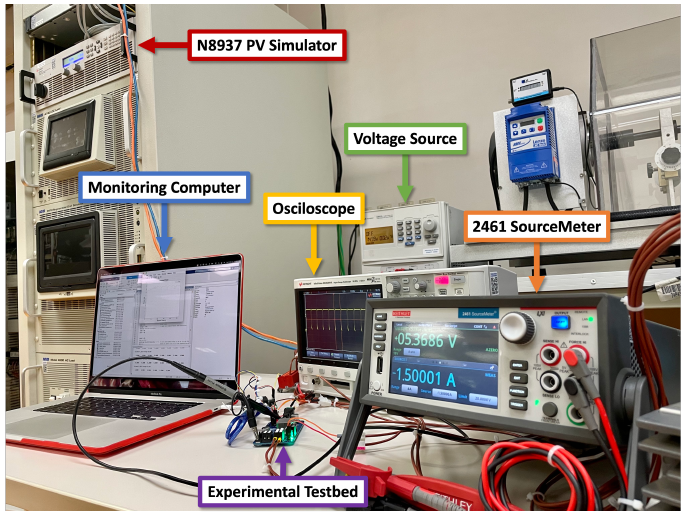
Figure 27. Laboratory equipment for the testbed experiments on the PV case study.